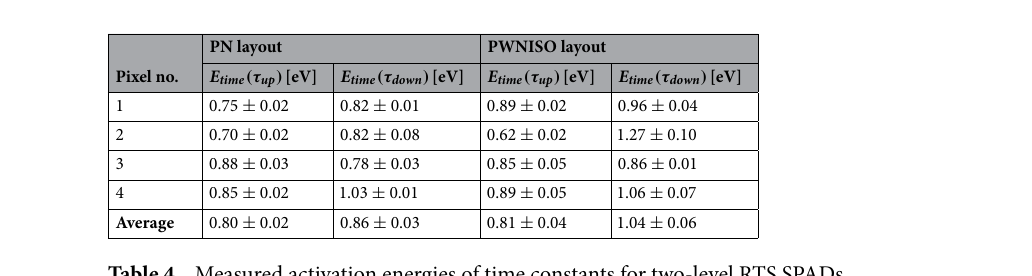
Table 4. Measured activation energies of time constants for two-level RTS SPADs.